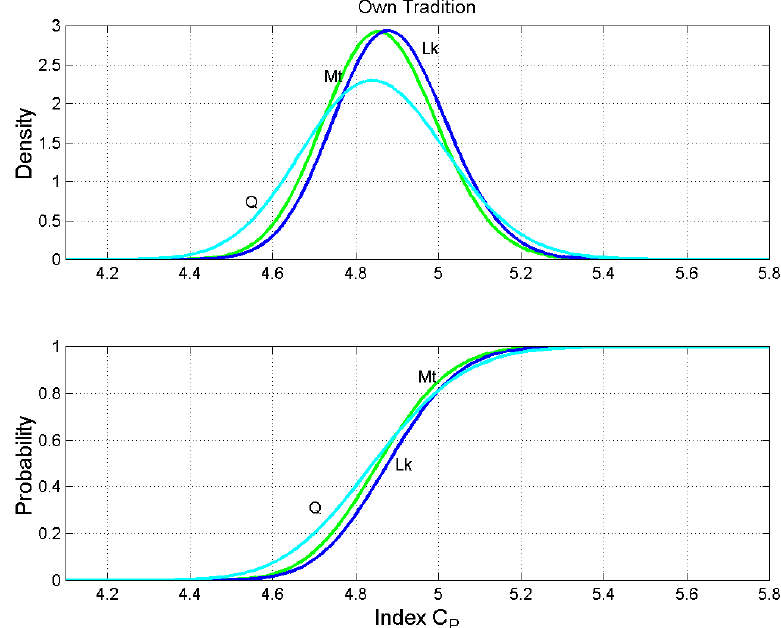
Figure 14. Own Tradition. Probability density functions (upper panel) and probability distribution functions (lower panel) of the number of characters per word 𝐶 𝑃 . Matthew : green line; Luke : blue line; Q : cyan line.